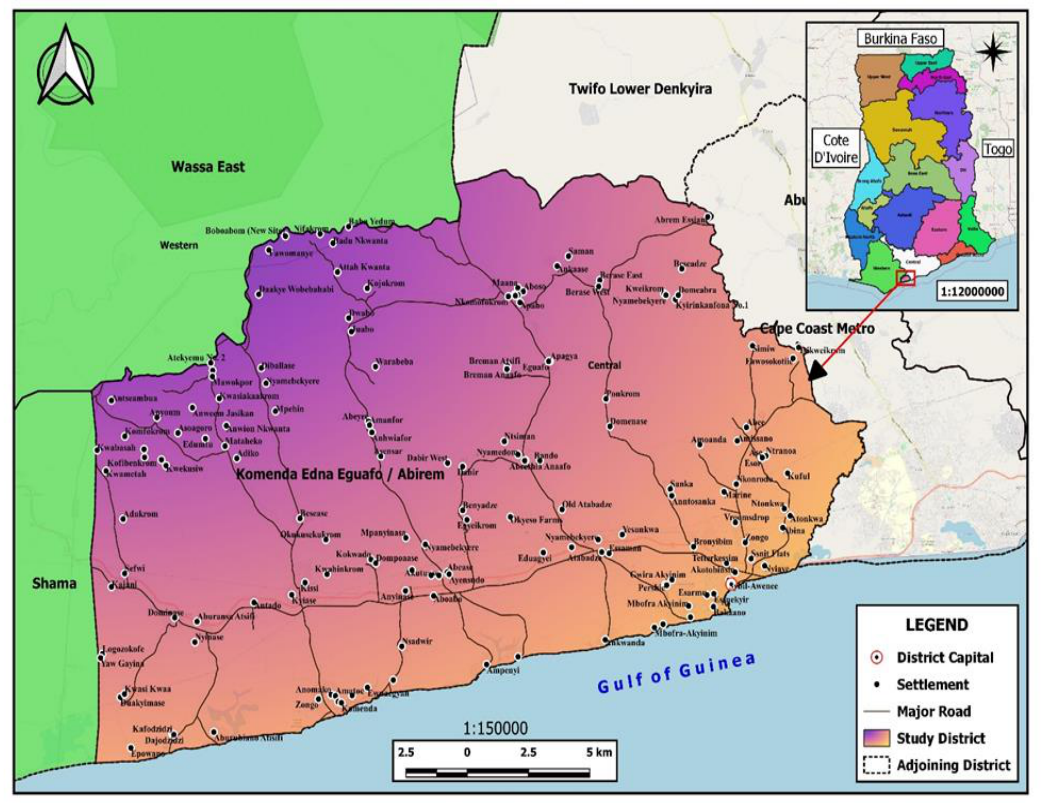
Figure 1: Location of KEEA Municipal Area